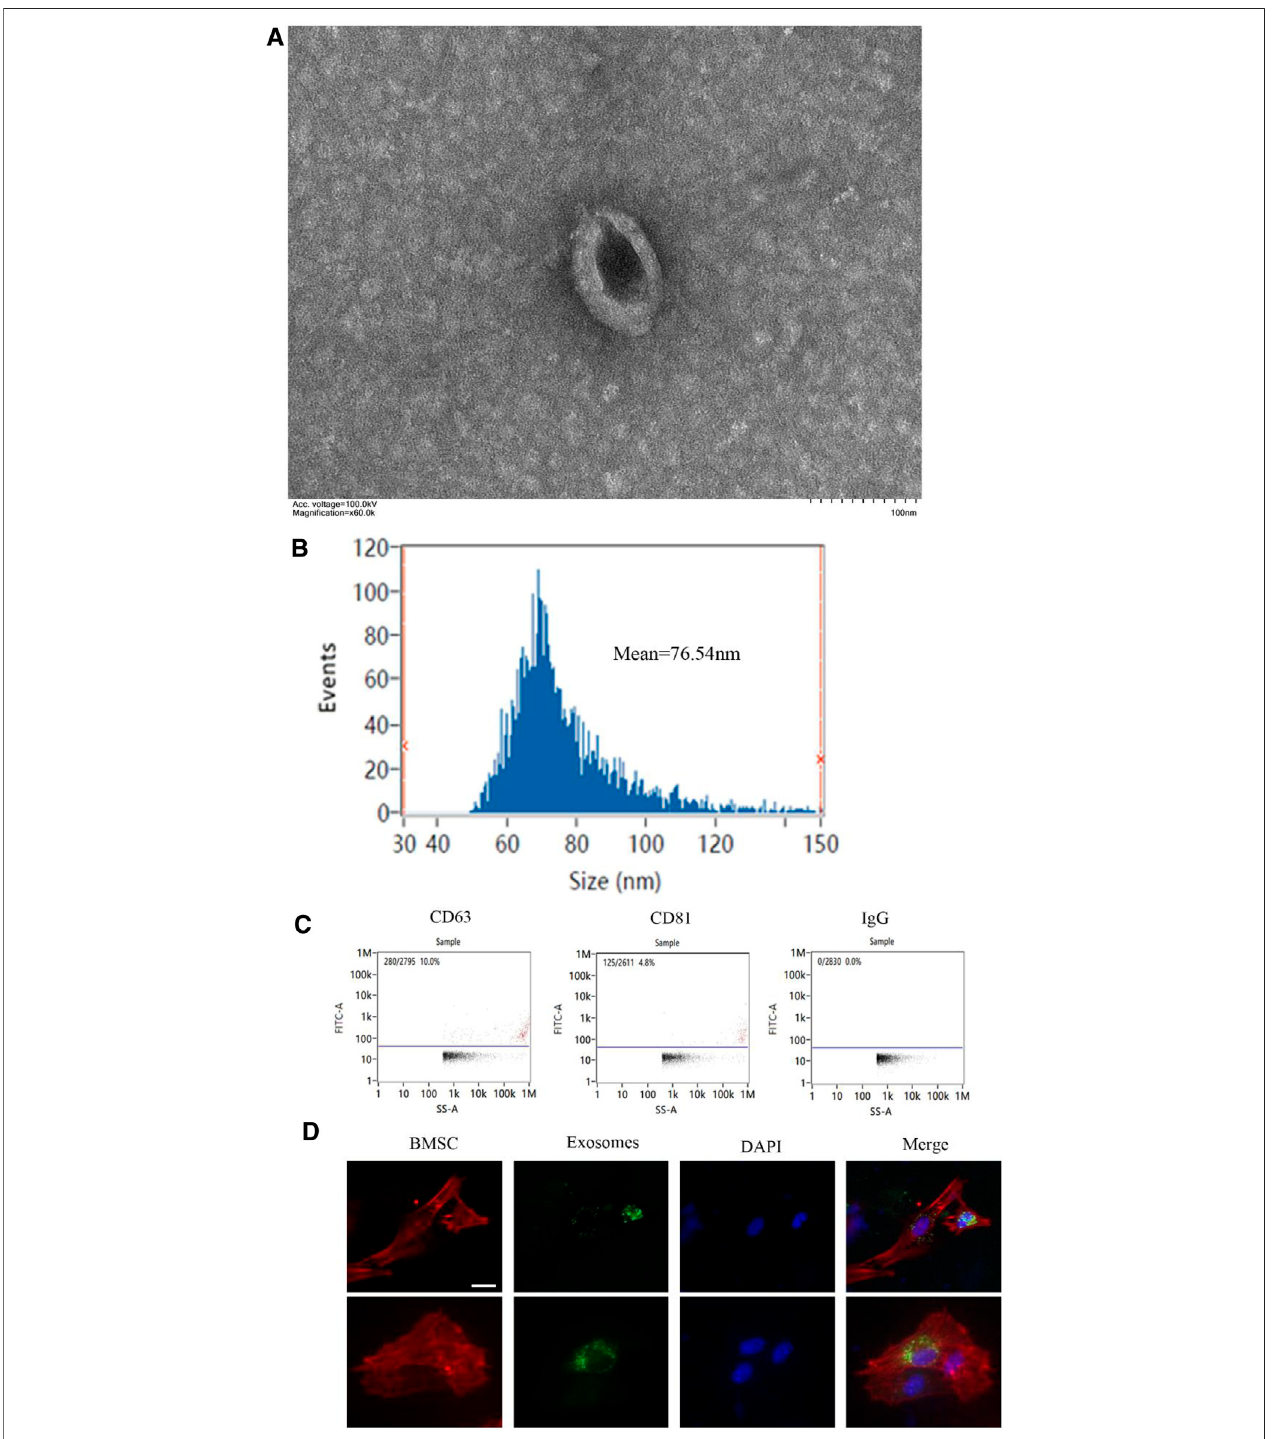
FIGURE1| Identi fi cationofexosomesgeneratedbymacrophages. (A) Themorphologyofexosomesundertransmissionelectronmicroscope(scalebar:100 nm); (B) Thesizedistribution curveoftheexosomes wasdeterminedbynanoparticletracking analysis; (C) Theexpression ofexosomemarkerproteinsCD81 andCD63was analyzedby fl owcytometry; (D) Representativeimmuno fl uorescenceimagesshowingtheinternalizationofPKH67-labeledBMDM-derivedexosomes(green)byBMSCs stained with phalloidine (red) at 6 h. Cell nuclei were stained with DAPI (blue), white arrows indicate exosomes(green).Scale bars, 10 μ m. * p < 0.05 and ** p < 0.01.